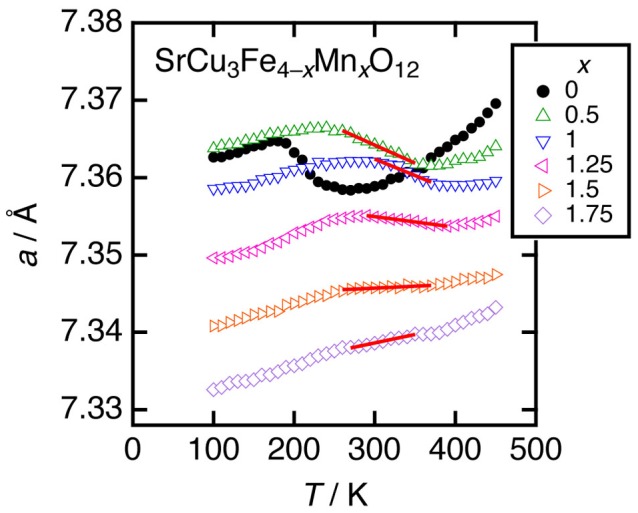
Temperature dependence of the cubic a-axis length for SrCu3Fe4–xMnxO12 (x = 0, 0.5, 1, 1.25, 1.5, and 1.75). Reprinted from [54] with permission from AIP Publishing LLC.